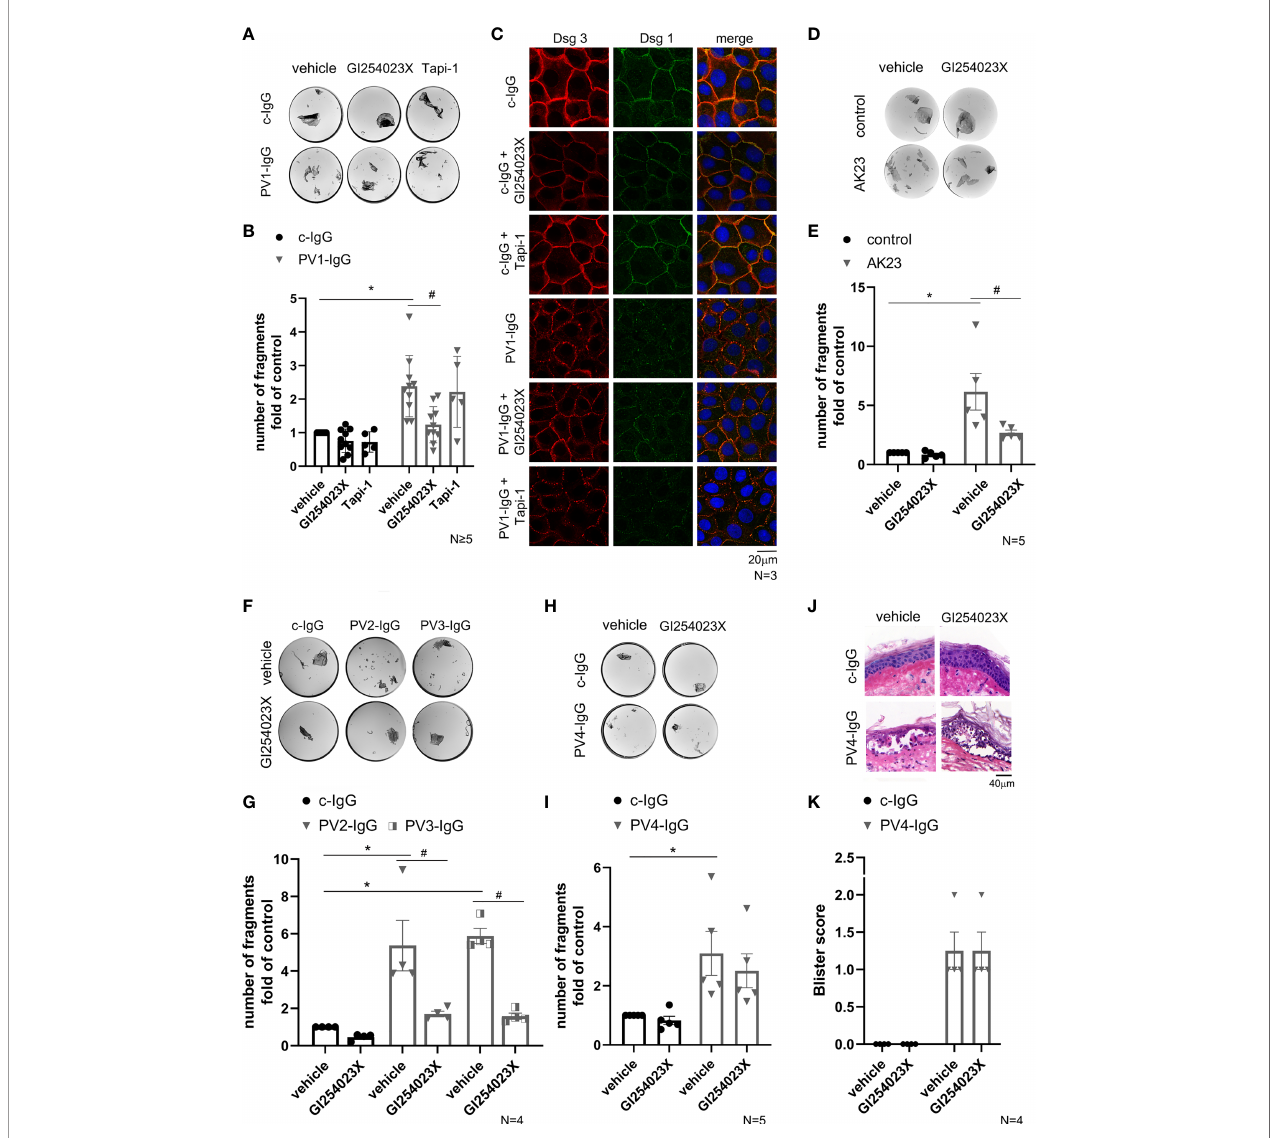
FIGURE 2 | ADAM10 inhibition ameliorated loss of intercellular adhesion in response to PV-IgGs with low Dsg1-levels and AK23. (A) Representative images of dissociation assays showed loss of cell adhesion in NHEK caused by PV-IgG compared to control autoantibodies from healthy volunteers (c-IgG). PV1-IgG in combination with inhibition of ADAM10 showed reduced cell sheet fragmentation. In contrast to ADAM10 inhibition, no protective effect was observed when PV1-IgG was co-incubated with the ADAM17 inhibitor. (B) Quanti fi cation of the assay showed a signi fi cant increase of cell sheet fragmentation after incubation with PV1-IgG (*p ˂ 0.0001) compared to the control condition (vehicle of c-IgG) and a reduction of cell fragments after co-incubation with GI254023X (#p=0.0016; n ≥ 5) compared to PV1-IgG alone. (C) Immunostaining under the same conditions showed a fragmented immunostaining of Dsg3 and Dsg1 after incubation with PV1-IgG which was ameliorated by ADAM10 inhibitor. The effect of ADAM10 inhibition was not detectable in cells incubated with Tapi-1. DAPI-staining proved the number and vitality of cells (n=3, scale bar: 20 µm). (D) Involvement of Dsg3 in this process was supported by analysis of the cell cohesion with incubation of AK23 in a dispase-based assay. (E) Quanti fi cation revealed the protective effect of GI254023X (#p=0.0387) vs. PV-IgG alone. Number of fragments were normalized to the control condition: vehicle of control (n=5). (F, G) Dispase assays after incubation with the mucosal PV2-IgG and PV3-IgG for 24 h leads to cell-cell fragmentation (PV2-IgG-vehicle: *p=0.0008 vs. c-IgG-vehicle and PV3-IgG-vehicle: *p=0.0002 vs. c-IgG-vehicle). Co-incubation with GI254023X revealed the protective effect of ADAM10 inhibition, when anti-Dsg1 autoantibodies are almost not present (PV2-IgG-vehicle vs. PV2-IgG-GI254023X: #p=0.0049 and PV3-IgG-vehicle vs. PV3-IgG-GI254023X: #p=0.0009). Number of fragments were normalized to c-IgG-vehicle. (n=4). (H) Representative images of a dissociation assay with PV4-IgG in combination with or without ADAM10 inhibitor. (I) After incubation with PV4-IgG for 24 h, a signi fi cant increase of cell fragments was detectable (*p=0.0401) which was not reduced by the ADAM10 inhibitor. Number of fragments were normalized to the control condition: vehicle of c-IgG (n=5). (J) Human skin samples were injected with PV4-IgG with or without GI254023X. HE staining of the skin samples showed no effect of GI254023X on PV4-IgG-induced acantholysis. (K) Blister score reveals no difference in absence or presence of ADAM10